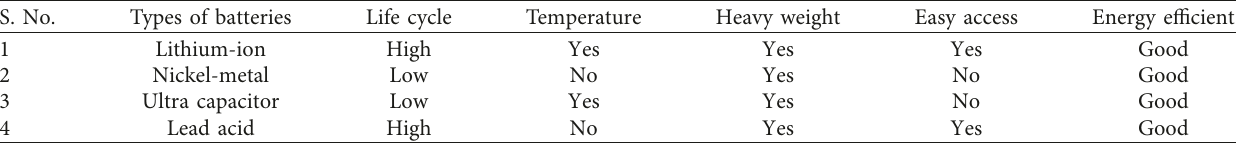
Table 1: Comparison of Li-ion